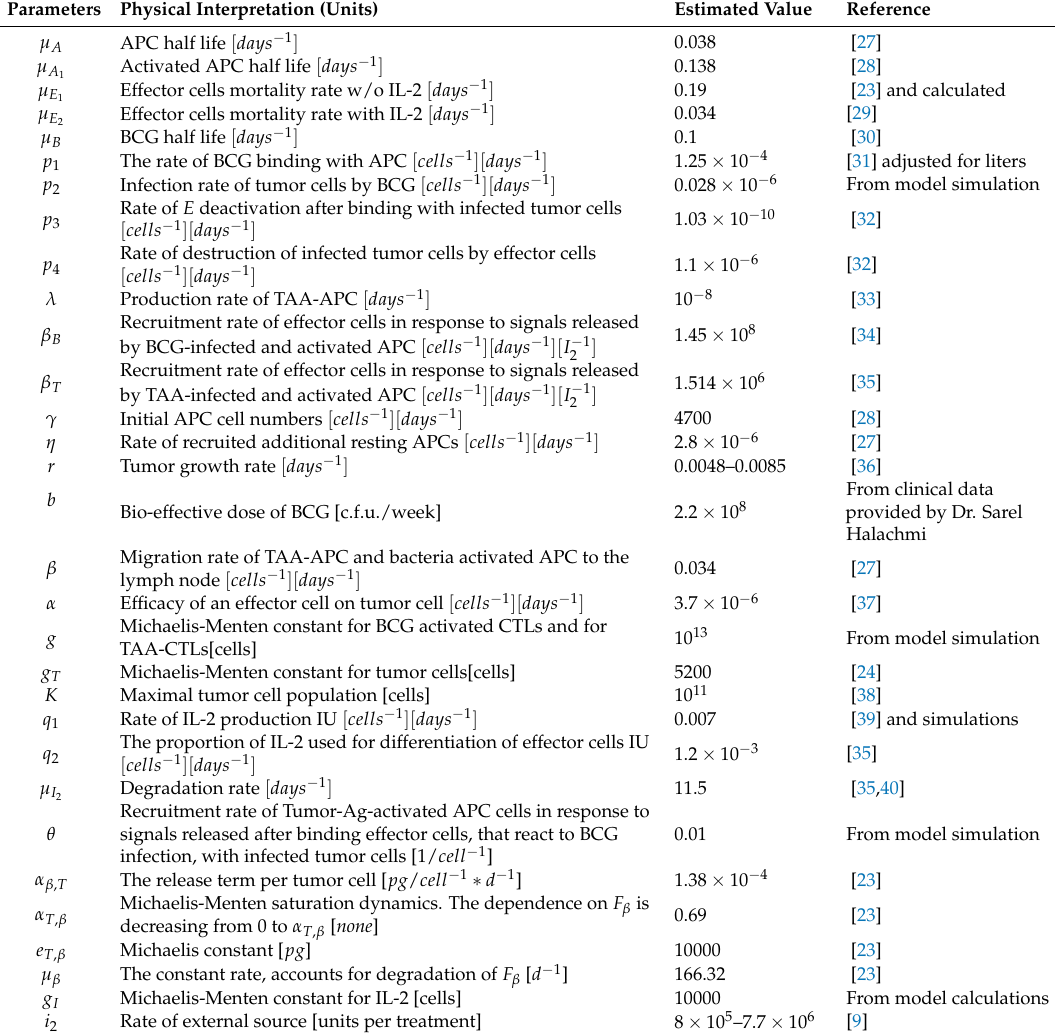
Table 1. List of all